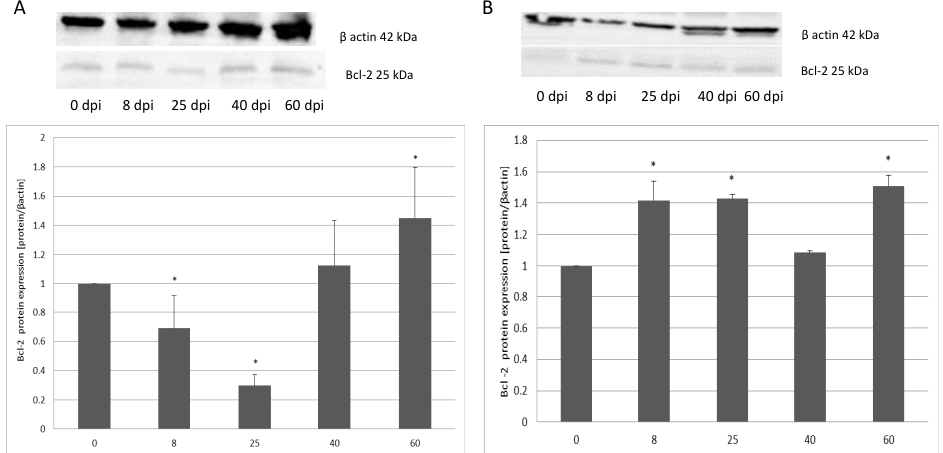
Figure 3. Representative Western blot bands and densitometric analysis of Bax protein level in the small intestine ( A ) and large intestine ( B ) from uninfected and H. diminuta -infected rats. Data rep- resent the arithmetic mean ± SD and are representative of individual groups of six animals in each experiment. Statistical analysis was performed using the Kruskal – Wallis test, * p < 0.05, vs. 0 dpi. The expression of anti-apoptotic protein Bcl-2 in the small intestine varied according to the duration of hymenolepiasis. Protein expression decreased significantly ( p < 0.05), by 32% at 8 dpi, and 70% at 25 dpi. On subsequent days, expression was higher vs. the control. At 40 dpi, expression increased by 13% (not significant) and at 60 dpi by 44% ( p < 0.05). In the colon of the infected rats, Bcl-2 protein expression was significantly higher at 8 dpi (41%), 25 dpi (43%), and 60 dpi (50%) compared to the uninfected rats ( p < 0.01) (Figure 4).